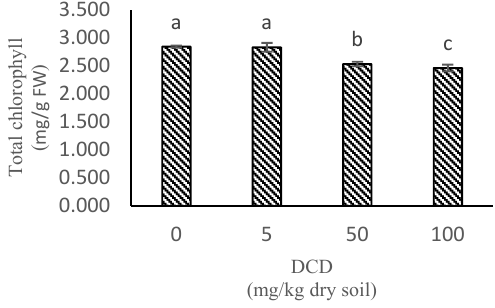
Figure 5. The main effect of dicyanodiamide in leaves of lettuce on total chlorophyll content. (The means refer to four repetitions ± SD. Different letters for each parameter indicate significant differ- ences assessed ( p < 0.05).)